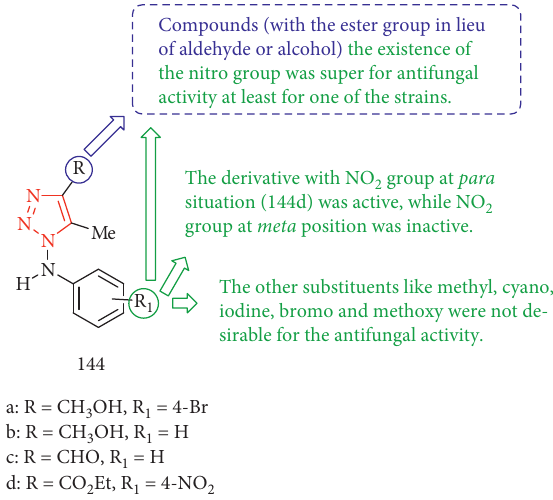
Figure 74: Chemical structure of 1,2,3-triazole phenylhydrazones as fungicide candidates.